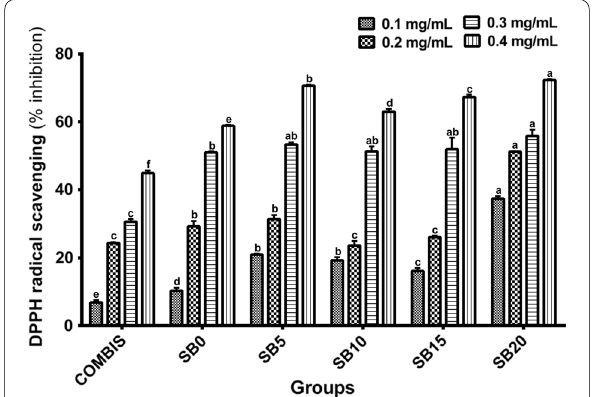
Fig. 3 DPPH inhibitory activities of plantain-shallot biscuits. Values are expressed as mean significantly different at p < 0.05. COMBIS: Commercial onion biscuit; SB0: 100% Plantain biscuit, SB5: 95% Plantain SD ( n 3). Bars with different ± = SB10: 90% Plantain 5% + 10% Shallot biscuit, SB15: 85% + 20% Shallot +